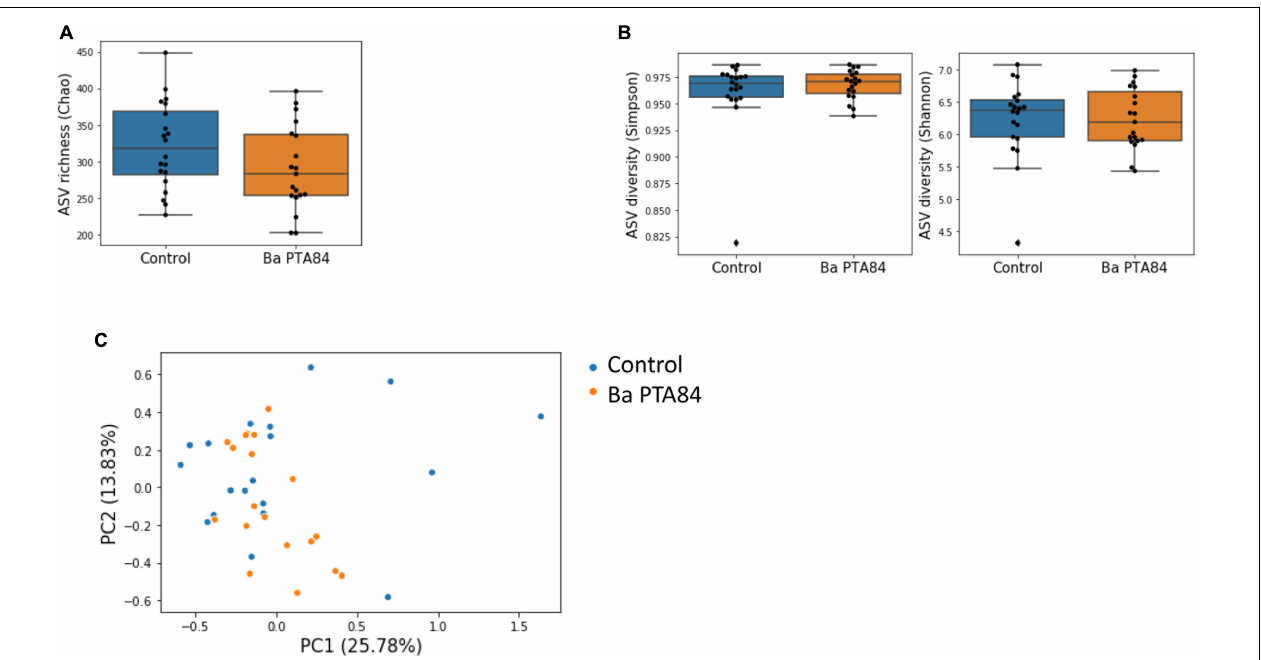
FIGURE 7 | Microbiome analysis of cecal content from birds fed with or without Ba PTA84. (A) ASV richness in the cecum of control birds and birds treated with Ba PTA84. Richness is quantified using the Chao index (Mann–Whitney U p -value = 0.07). (B) ASV diversity quantified with the Simpson (left) and Shannon indexes (right) for control birds and birds treated with Ba PTA84. ( p -value = 0.44, 0.36). (C) Principal component analysis of the Bray–Curtis dissimilarity matrix between microbiome profiles for control birds and birds fed with Ba PTA84. Each dot represents a cecal sample. Numbers in parentheses indicate the variance explained by each principal component.